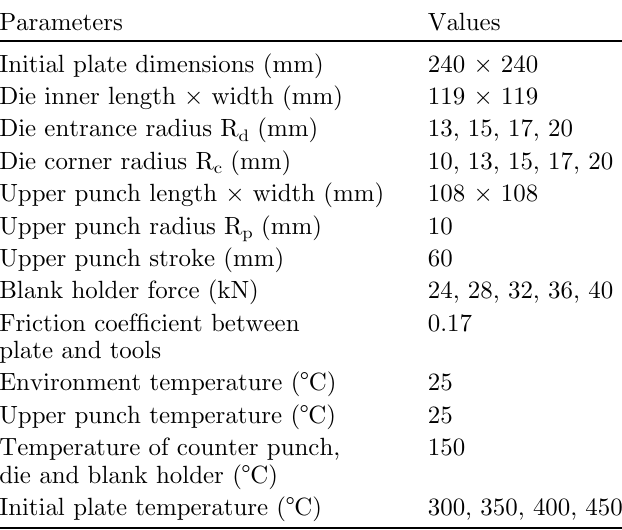
Table 1. Hot stamping parameters of square cup